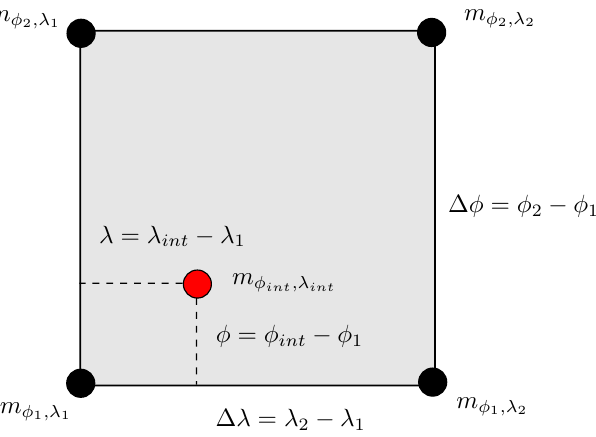
Figure 6. Geometry for bilinear interpolation of the refractive index at aircraft coordinates m φ using the surrounding refractive indices m φ